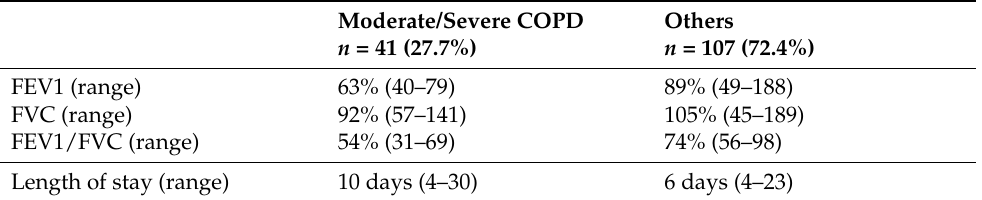
Table 5. Postoperative outcomes according to respiratory function after robotic pulmonary